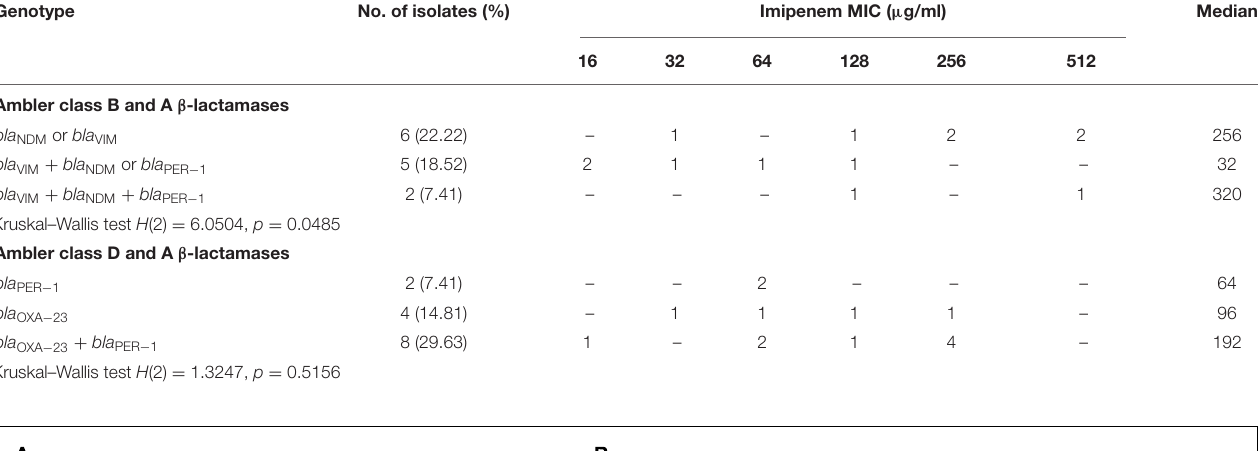
TABLE 3 | Prevalence of β - lactamase-encoding genes with the corresponding imipenem minimum inhibitory concentration (MIC) distributions for 30 isolates of Acinetobacter baumannii. Genotype No. of isolates (%)